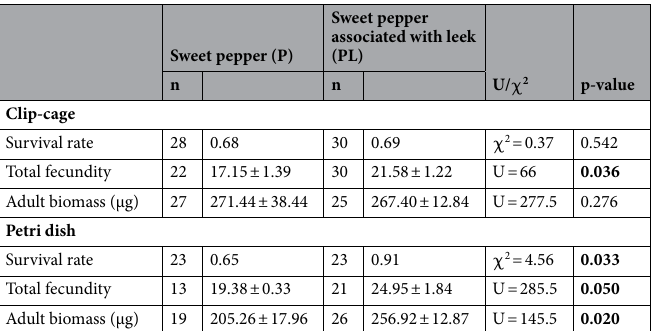
Table 2. Comparisons of fitness parameters (means + /- SEM) of M. persicae reared on sweet pepper with (PL) or without (P) associated leek in clip-cage and in Petri dish. P values < 0.05 (Mann–Whitney U-test and Cox Model) are written in bold; n: sample size; χ 2 : Chi